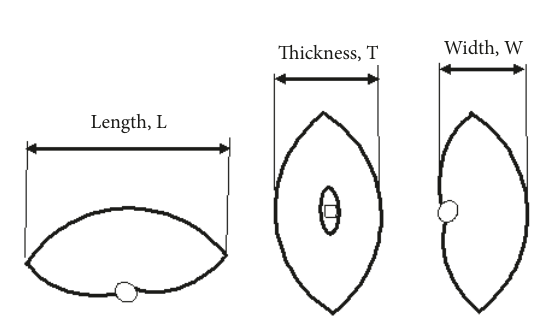
Figure 2: Common bean principal